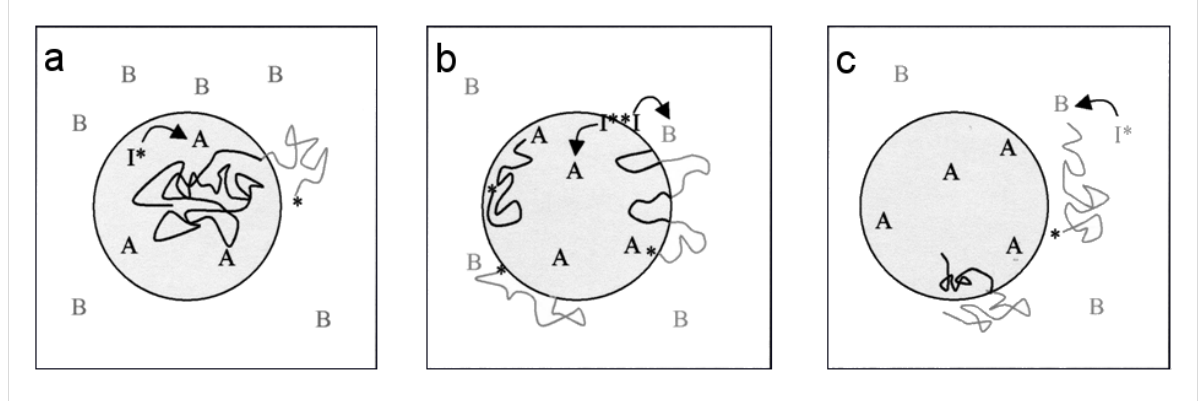
Figure 1: Copolymerization of 2 monomers A and B with different polarities in direct miniemlusions with the decomposed initiators I * which are a: oil- soluble, b: surface active, c: water-soluble (reproduced with permission from [27]. Copyright (2002) Wiley-VCH Verlag GmbH & Co, KGaA).